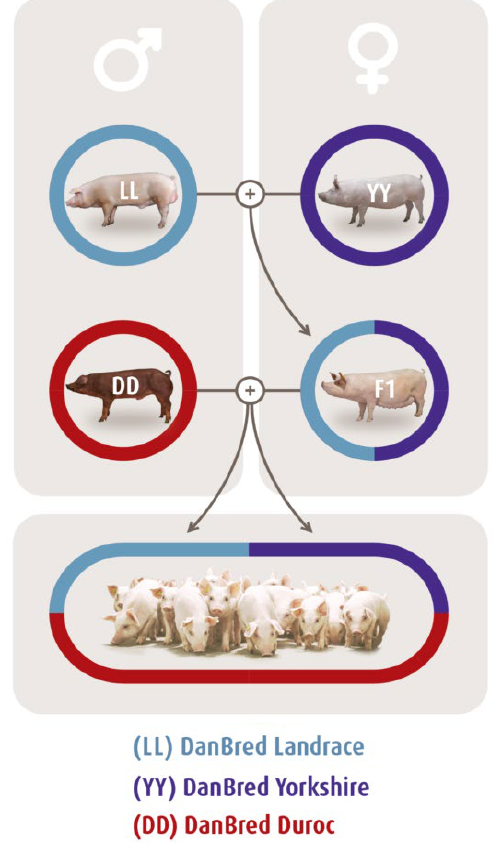
Fig. 2. Scheme of a complex three-breed industrial crossing (https://danbred.com/ru) The conditions for keeping sows and suckling piglets were provided with equipment, farrowing pens, a ventilation system, feed transportation, and feeding manure removal in building No. 3 – the French manufacturer I-TEK (Fig. 3).